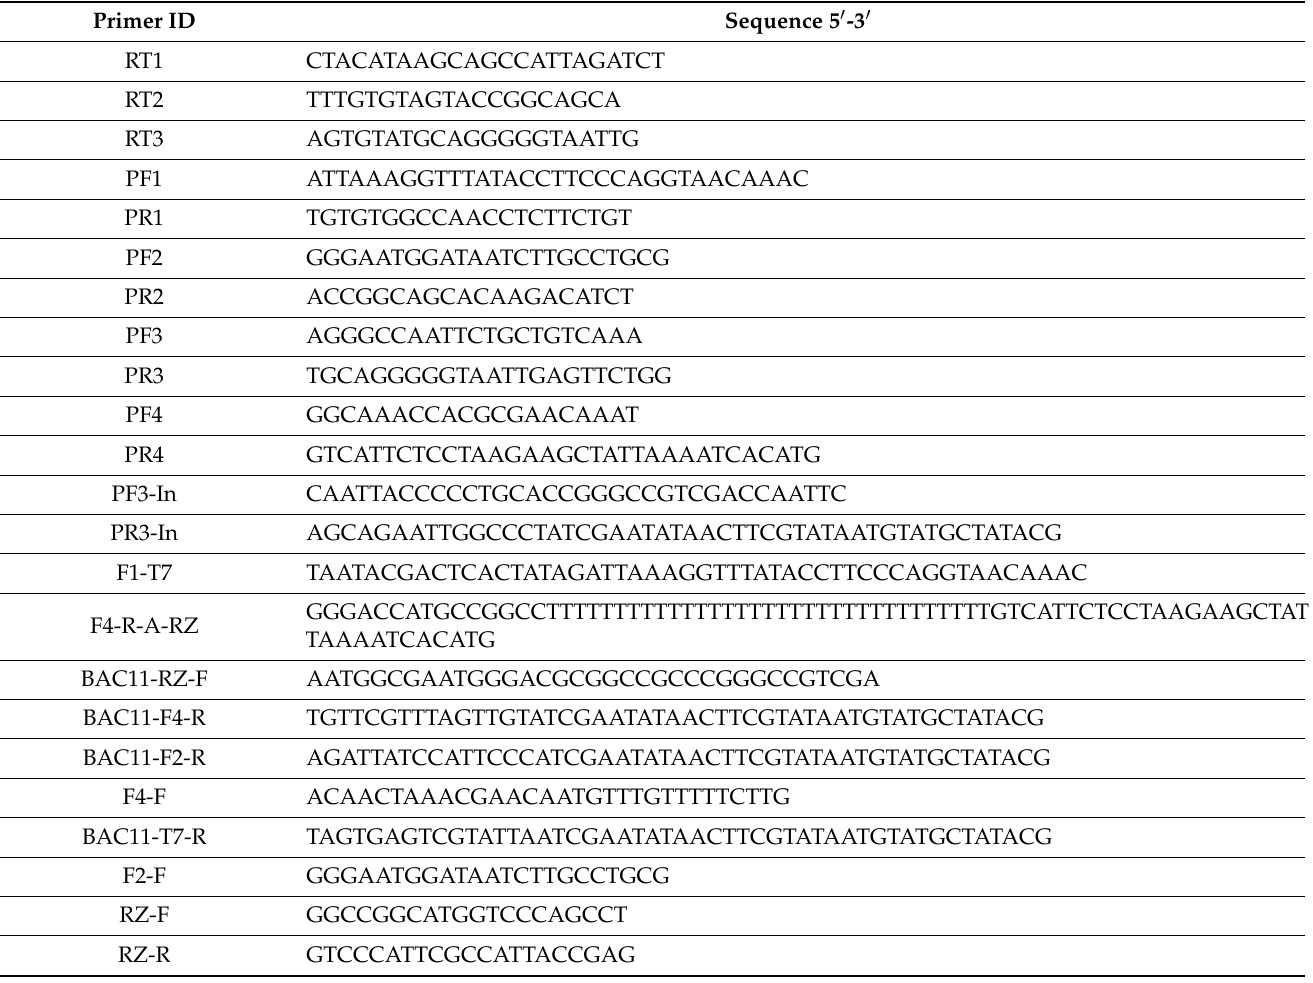
Table 1. Primers used to amplify and clone